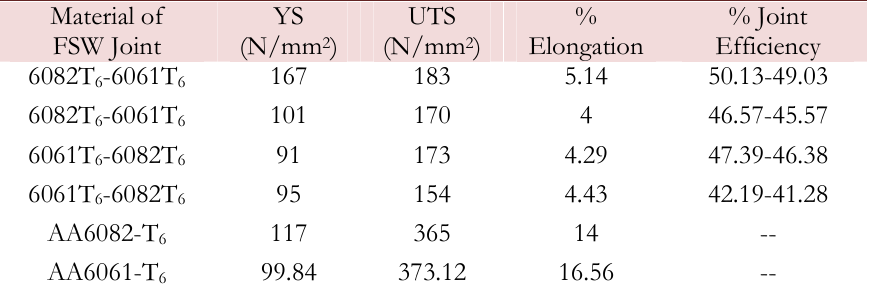
Table 4: Mechanical properties of dissimilar FSW